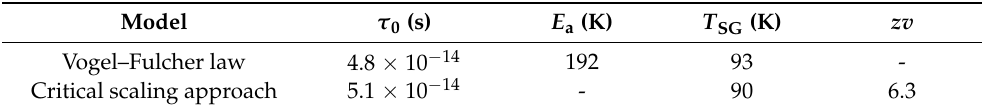
Figure 7. Fitting results of T f_ac shift in χ ac’ ( T ) using ( a ) Vogel–Fulcher law and ( b ) critical scaling approach for FeRhIrPdPt, respectively. Table 3. Fitting parameters obtained by Vogel–Fulcher law and critical scaling approach for FeRhIrPdPt.